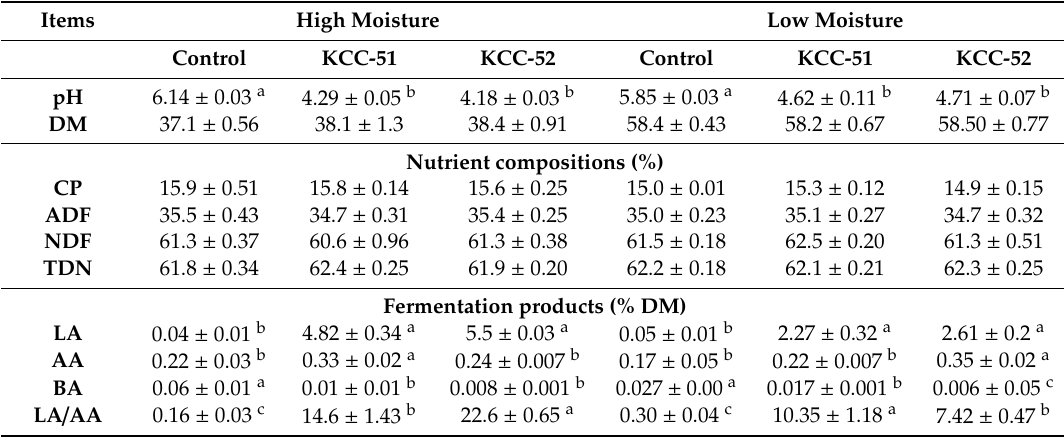
Table 2. Nutritional contents (%) and fermentative characteristics (%DM) of low and high moistures silages of triticale in non-inoculated and inoculated (KCC-51 and KCC-52) silages of triticale at high and low